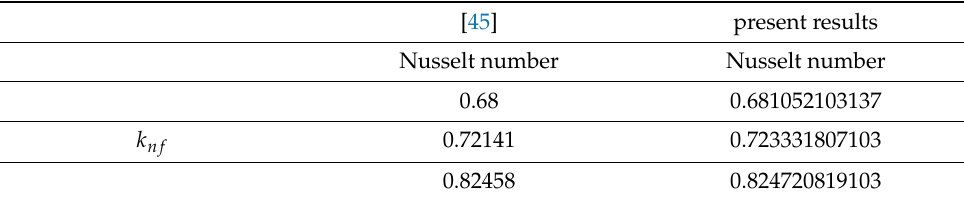
Table 3. Comparative study of a temperature gradient with published results of Qureshi et al. [45] in the case of nanofluid.